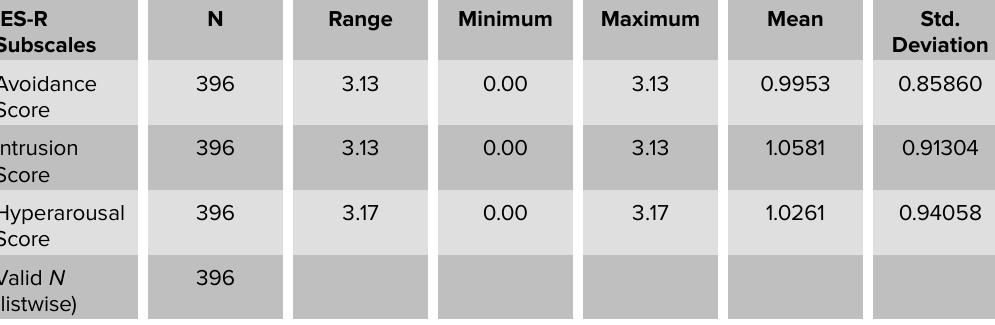
TABLE 5: IES-R subscales among participants